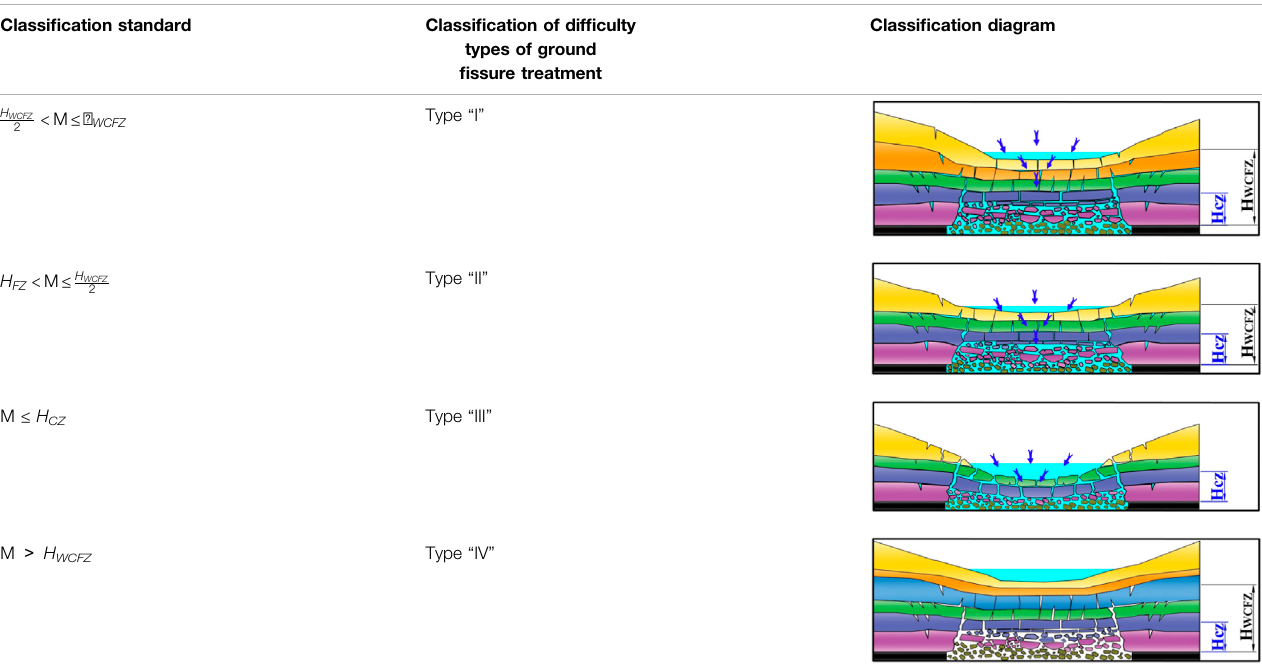
TABLE 5 | Classi fi cation of gully ground fi ssures for